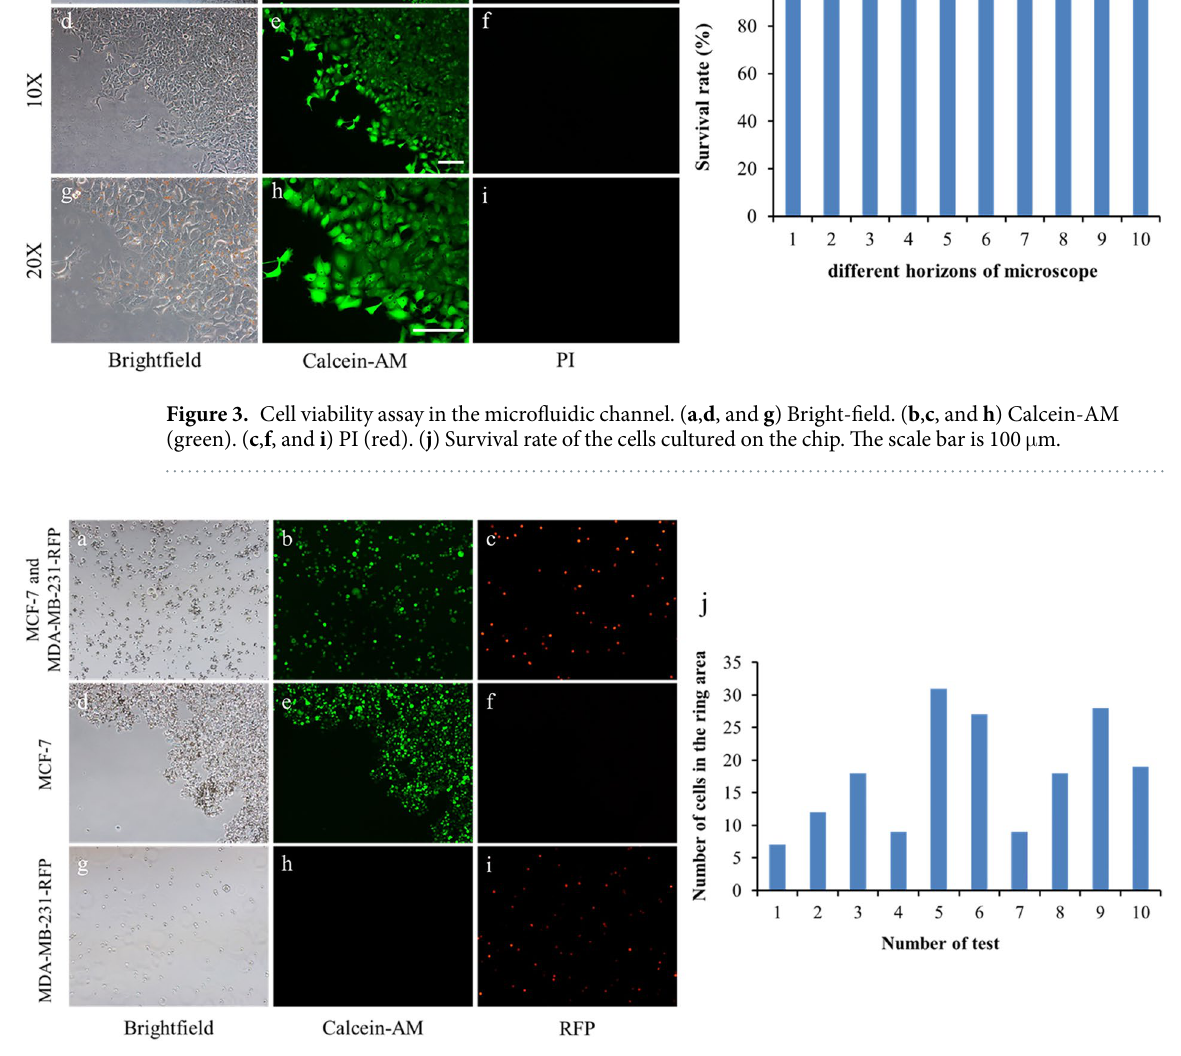
Effects of TGF- β on MCF-7 cell migration.